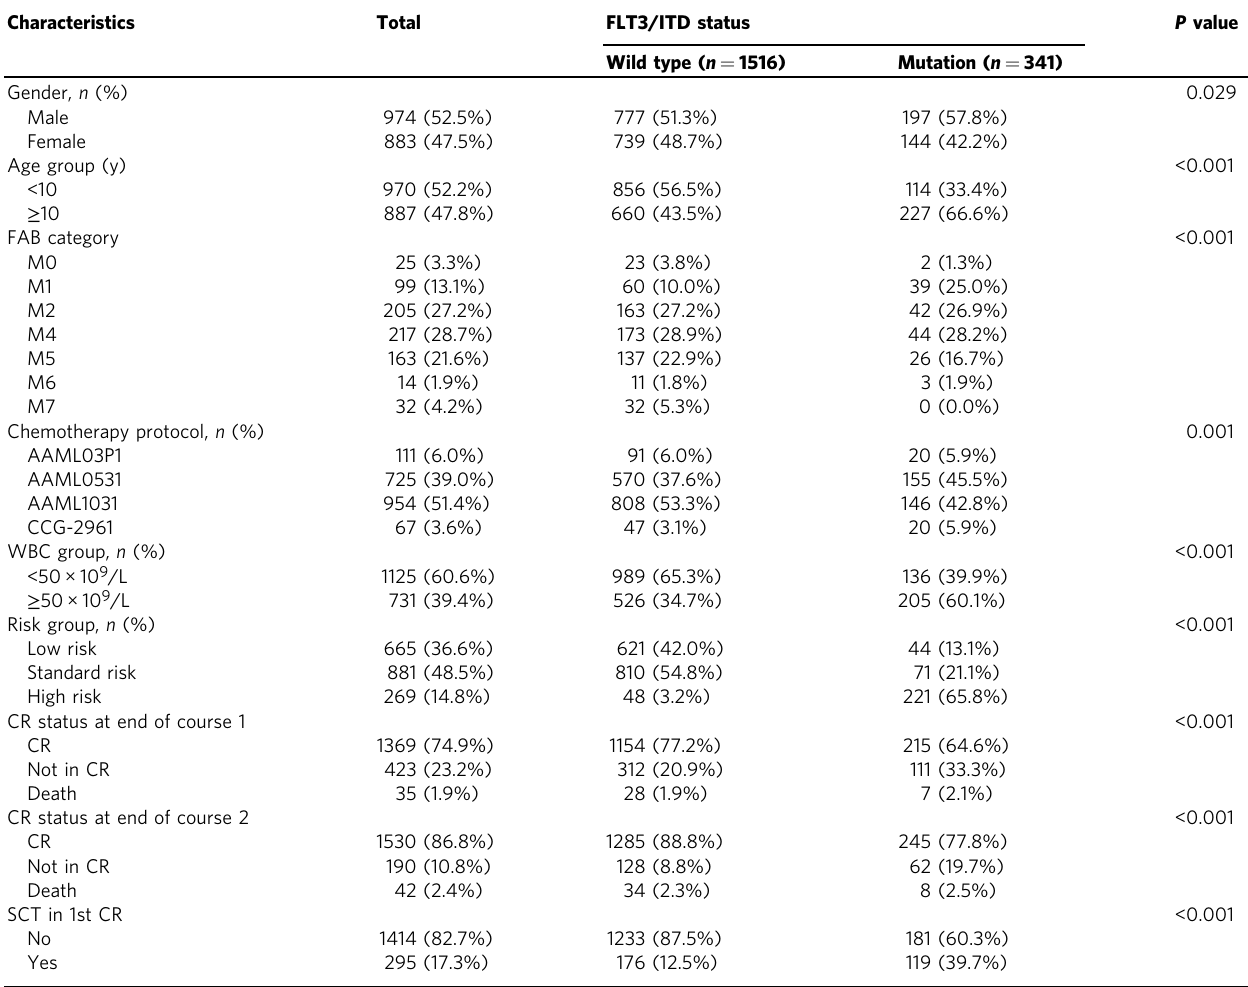
Table 1 Baseline characteristics of study participants by FLT3/ITD status classi fi cation.